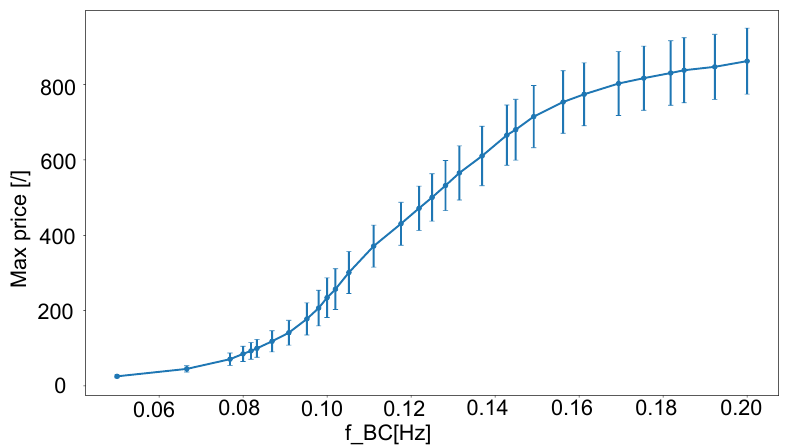
Figure 18. Maximum price of provided services in the game for different frequencies of transac- tion